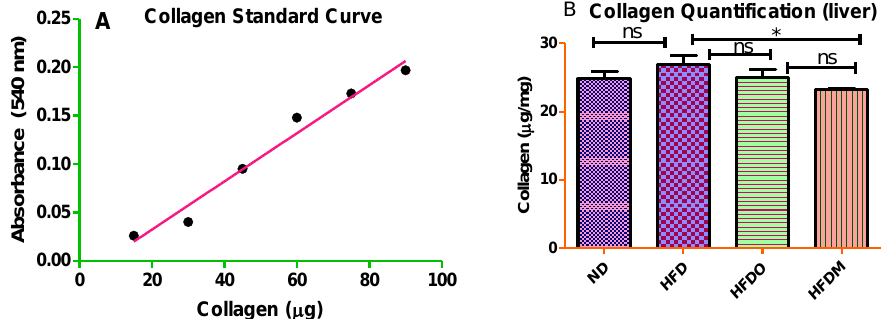
Figure 13. Effect of a high-fat diet on hepatic fibrosis. Treatment with MESK significantly reduced collagen deposition in the liver. ( A ) Collagen standard curve and ( B ) bar graphs representing total collagen as micrograms of collagen/mg of liver tissue ( p < 0.05; * 0.048 between HFD and HFDM). (ND: normal diet, HFD: high-fat diet, HFDO: HFD + Orlistat, HFDM: HFD + MESK).